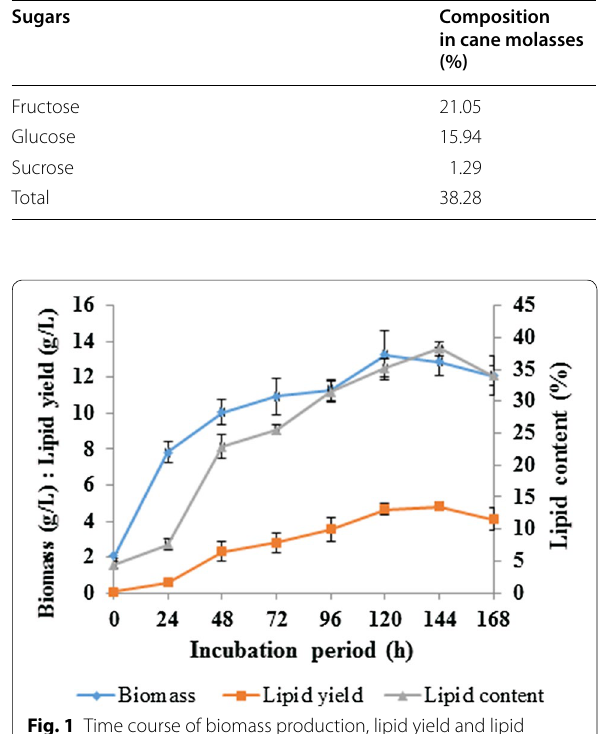
Fig. 1 Time course of biomass production, lipid yield and lipid content by R. kratochvilovae SY89 using molasses as a substrate in stirred tank bioreactor. Error bars in the figures represent standard